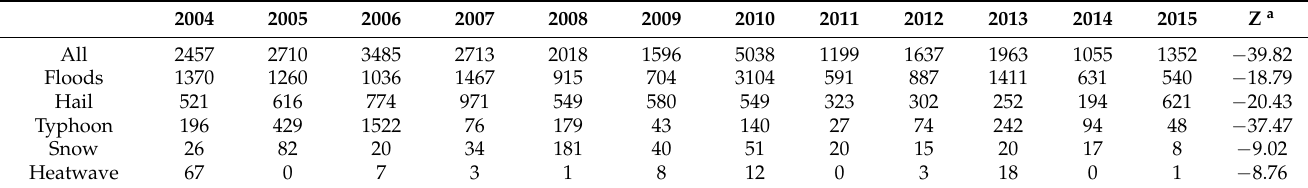
Table 1. Meteorological disasters related deaths from 2004 to 2015 and result of time trend analysis.